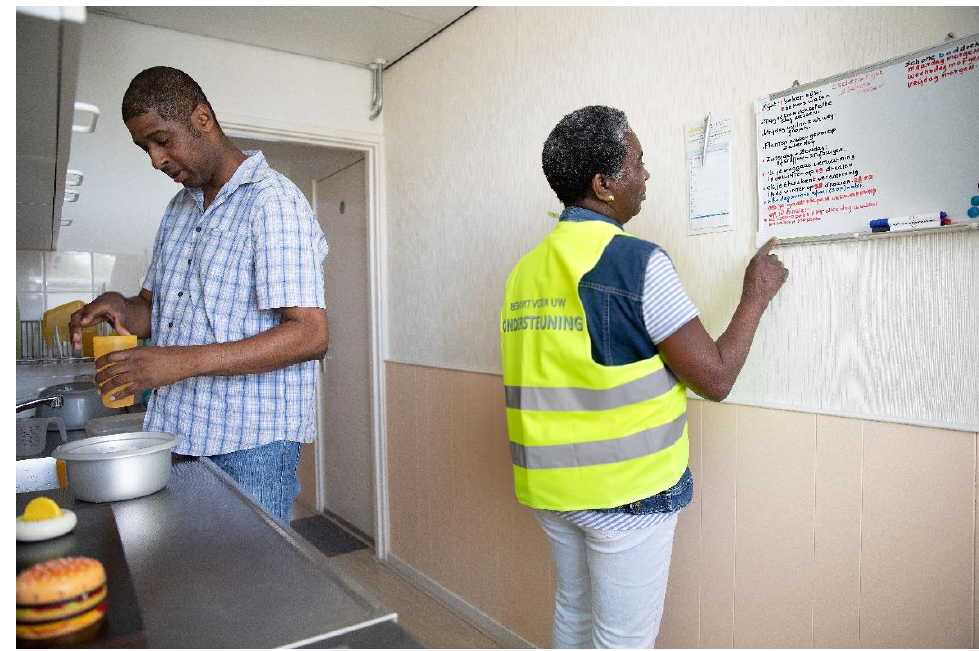
Figure 7. Picture of community researcher doing unpaid care work wearing yellow vest.